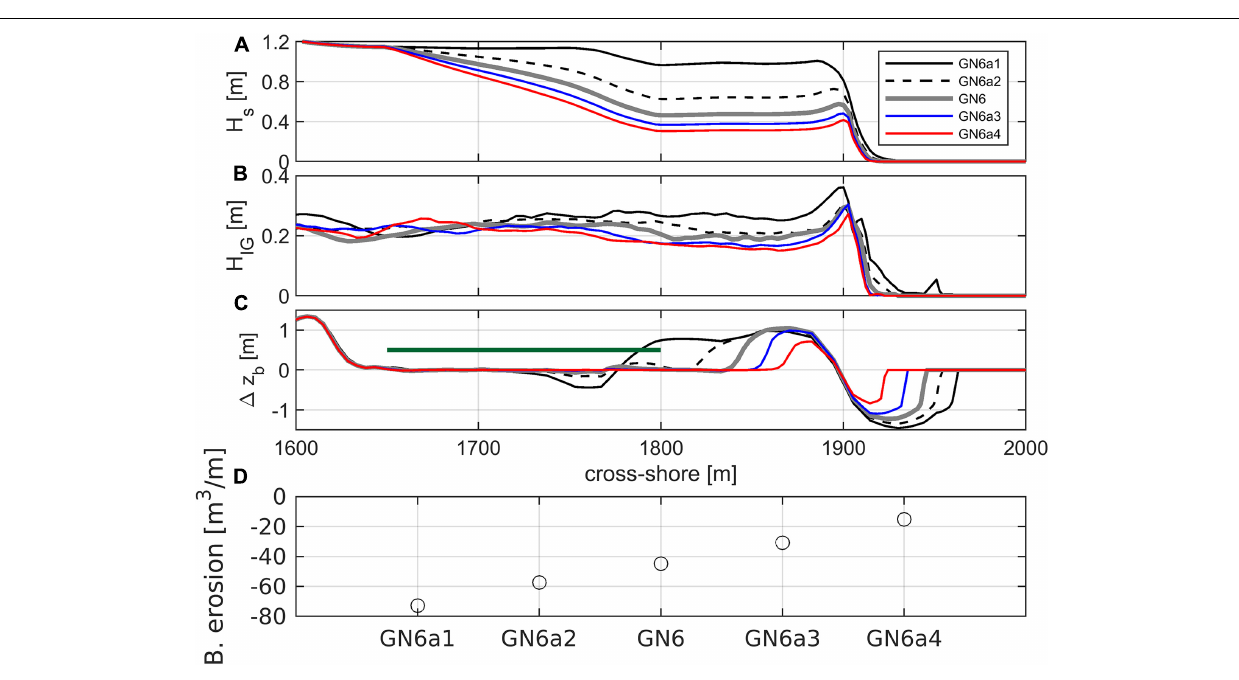
erosion after 100 days of mild wave condition was lower in GN6 than GREF, i.e., 44.8 m 3 /m compared with 71.4 m 3 /m. Similarly, beach erosion after the storm event was about 91 m 3 /m,